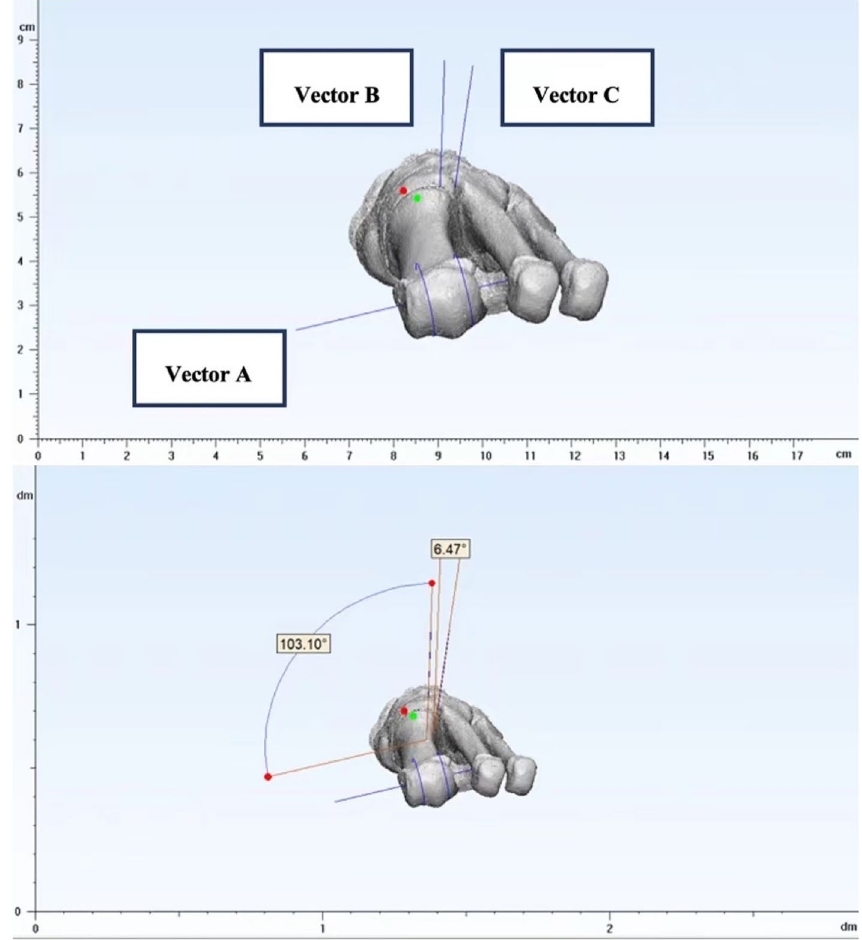
Figure 7. The definition of first MT torsion angle and TMT joint rotation angle.